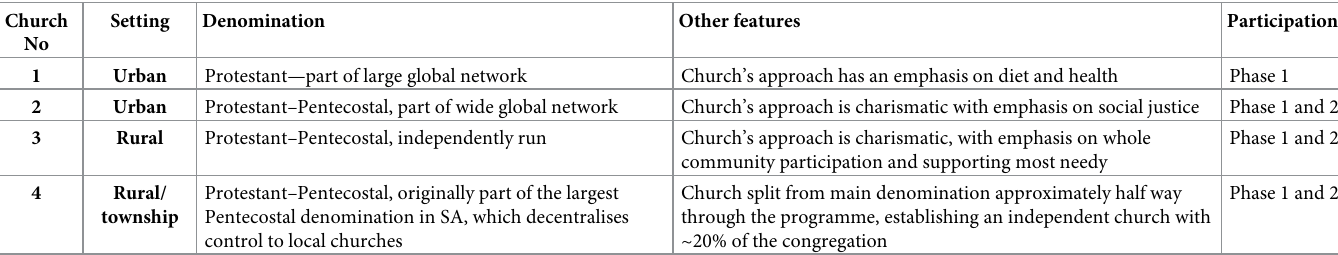
Table 1. Characteristics of the participating